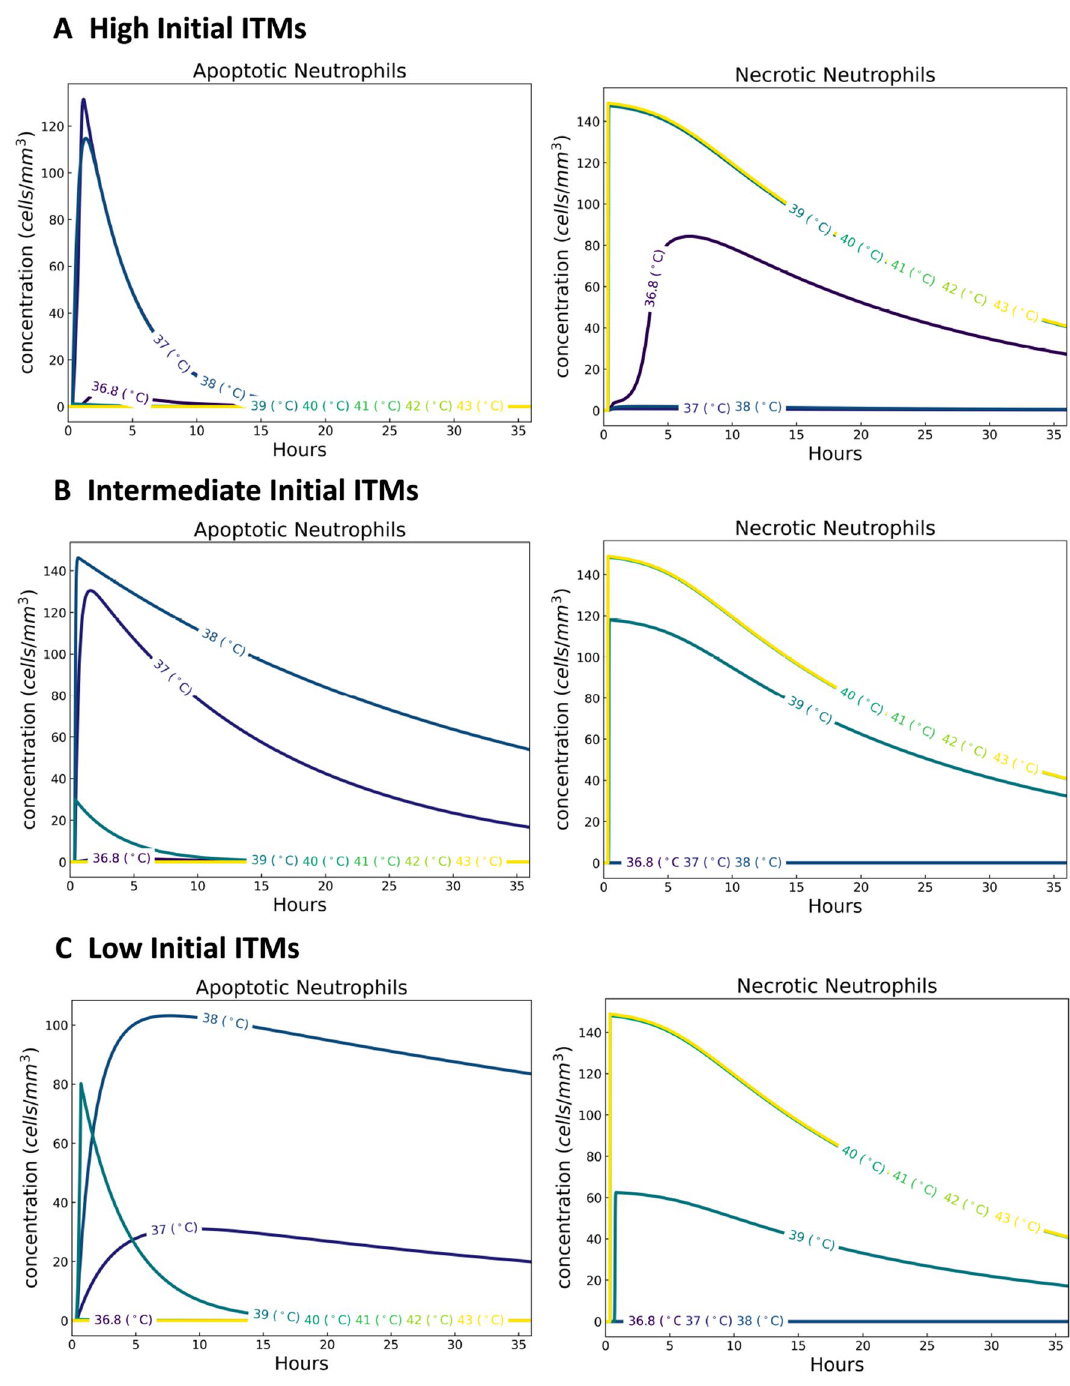
Figure 8. Dynamics of neutrophils for a temperature-dependent human innate immune system. For temperatures within the mild febrile range (37, 38] ◦ C , results show higher concentrations of apoptotic neutrophils, but lower concentrations of necrotic neutrophils, supporting the beneficial effect of fever to the human innate immune Innate immune response in three different activities. Neutrophils. Simulation results for the con- centration of apoptotic and necrotic neutrophils for the three physical activities are summarised in Fig. 10. Mar- athon triggers the highest concentration of apoptotic neutrophils, followed by construction work and walking. Higher concentrations of ITMs trigger HIIS to go into the necrotic death pathway. Necrosis in turn aggravates the ongoing inflammation by encouraging the recruitment of more circulating neutrophils into the site of in- flammation, This is why we see a higher level of induced necrotic neutrophils in Fig. 10B for the marathon scenario.